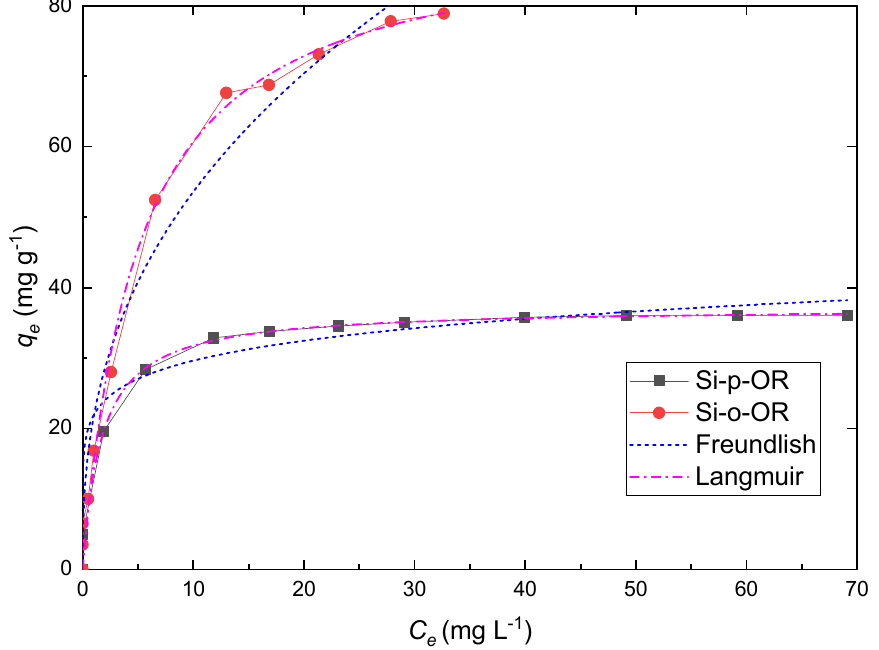
Figure 8. Effect of initial concentration on copper ion adsorption onto Si-o-OR and Si-p-OR and adsorption isotherms of both adsorbents towards Cu(II), fitted according to Langmuir and Freundlich models. Adsorption conditions: 10 mg, V = 10 mL, [Cu(II)] = 10 to 300 mg L − 1 , pH = 6, time = 25 min at 25 °C.